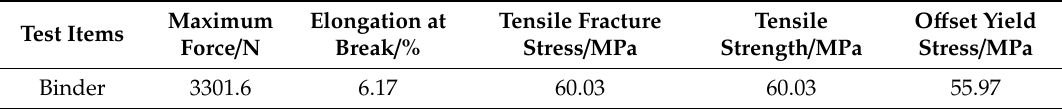
Figure 8. Stress-strain curve of resin specimen. Table 4. Tensile test data.